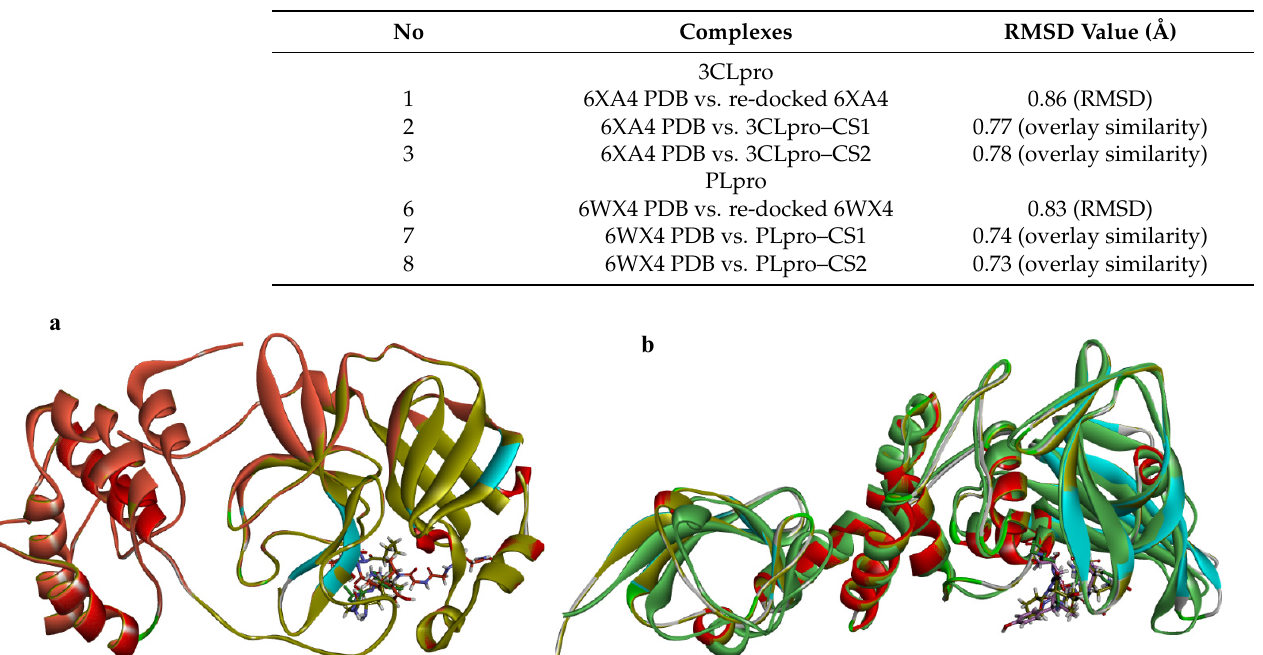
Table 2. Root-mean-square values (in Å), or overlay similarity of the superimposed amino peptide residues of re-docked complexes with native and docked complexes considered in this study.